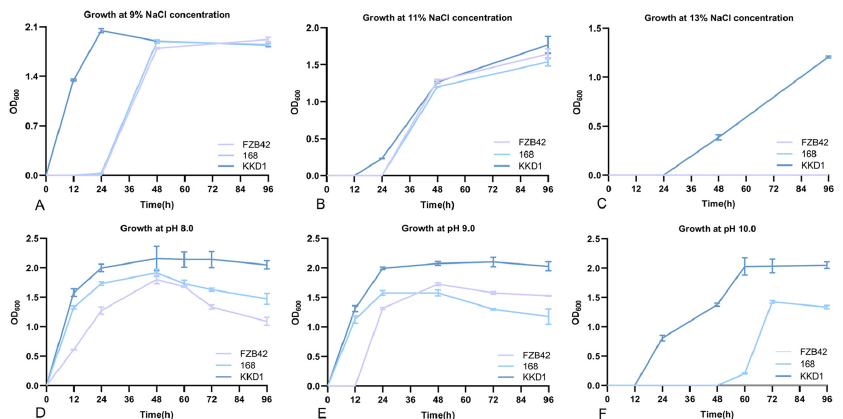
Figure 6. Growth curve of B. halotolerans KKD1 under different stress conditions. Growth curve under salt stress (9%, 11%, 13%) and growth curve under alkaline stress (pH 8.0, pH 9.0, pH 10.0). The error bars represent the mean standard deviation of each treatment repeated three times with three replicates ( A – F ).